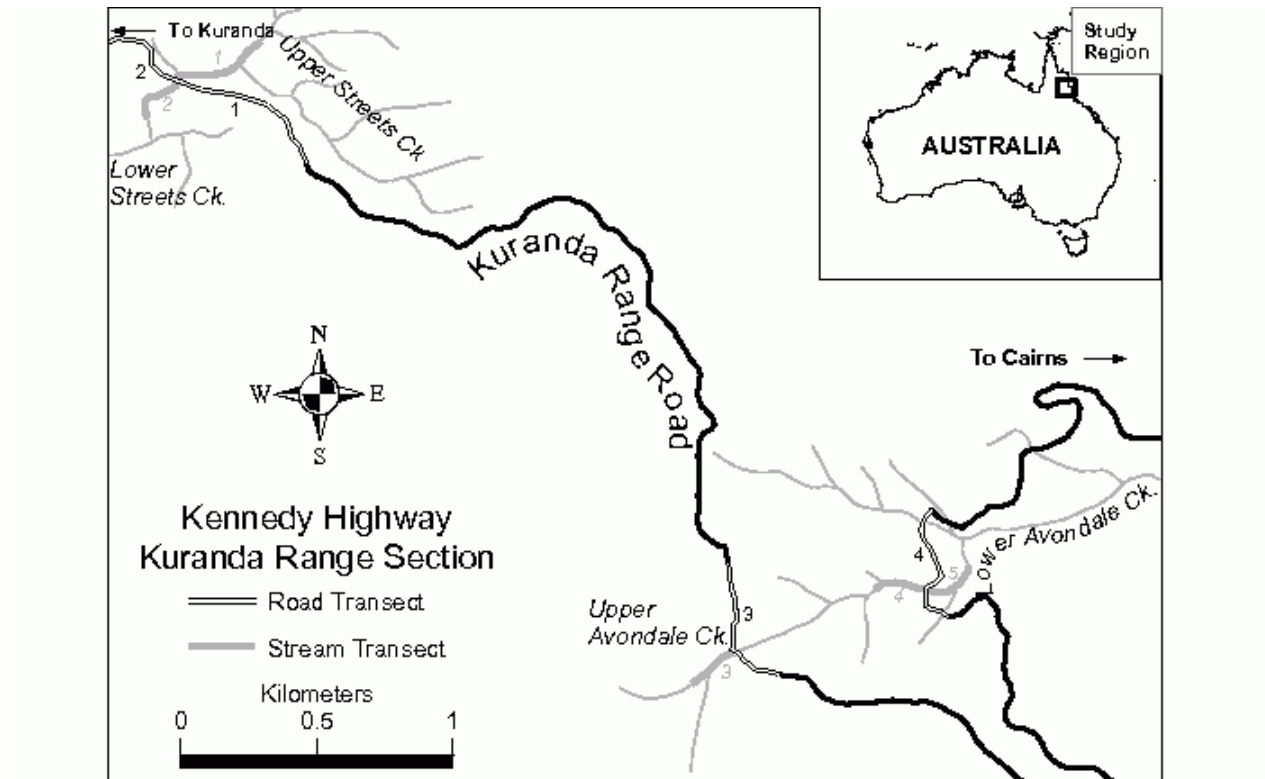
Fig. 1 . Map of the study region, showing location of the stream and road transects. Stream transects are marked by thickened grey stream and numbered in grey as: (1) upstream Streets Creek, (2) downstream Streets Creek, (3) upper Avondale Creek, (4) lower Avondale Creek upstream, (5) lower Avondale Creek downstream. Road transects are marked as open sections of road and numbered in black as: (1) upstream Streets Creek, (2) downstream Streets Creek, (3) upper Avondale Creek, (4) lower Avondale